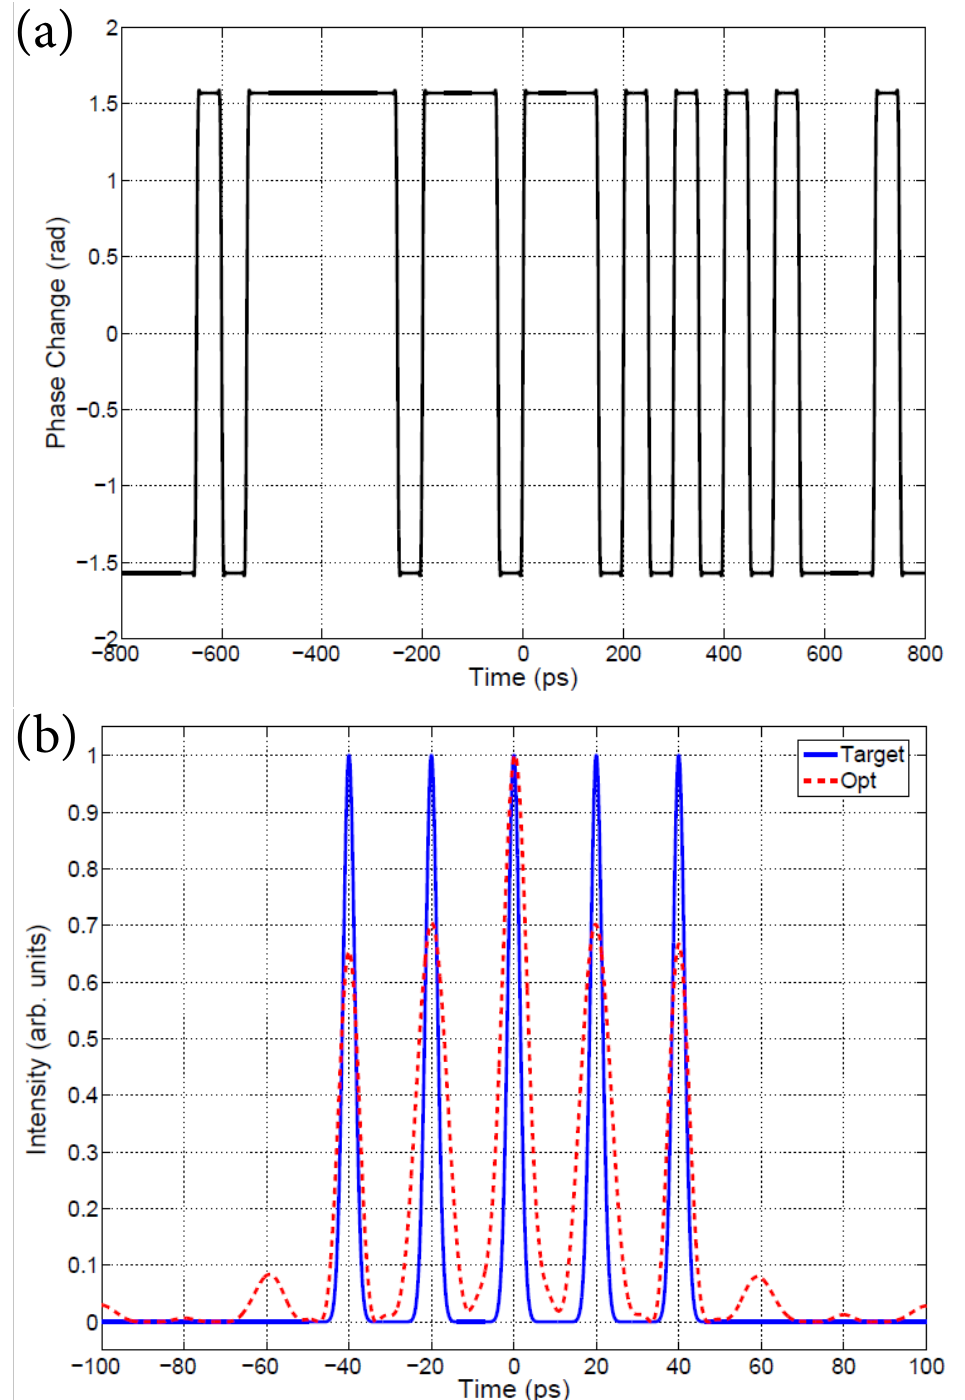
Figure 5. Brute Force MC optimization. ( a ) Optimal phase modulation code. ( b ) Target and optimized temporal intensity